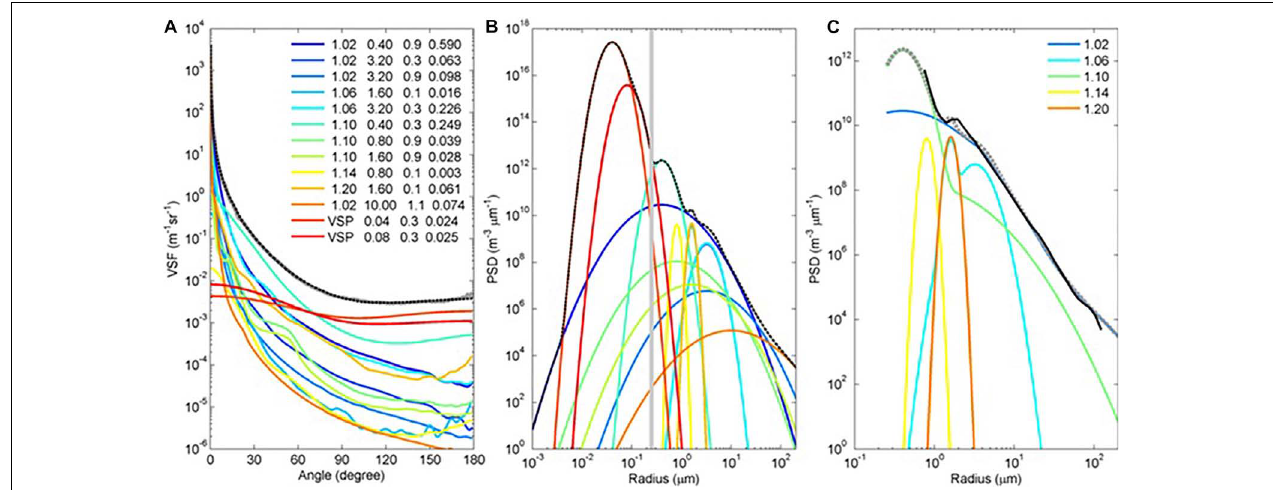
FIGURE 3 | An example demonstrating representing a measured VSF using various particle subpopulations. (A) The measured VSF (gray line) was disaggregated into subpopulations, whose corresponding refractive index, the mode size and standard deviation, and the scattering coefficient are shown in the legend. The dotted black line is the reconstructed VSF from these subpopulations. (B) Log-normal size distributions estimated for each of the subpopulations identified in panel (A) . The vertical gray line represents the filter size that commonly used in oceanography to partition particles into particulate and dissolved fractions. (C) The size distribution of subpopulations the particulate fraction are grouped by the refractive indices (shown in the legend). The dotted gray line is the bulk size distribution estimated by summing individual subpopulations. The black line is the size distribution independently derived from the LISST for comparison.